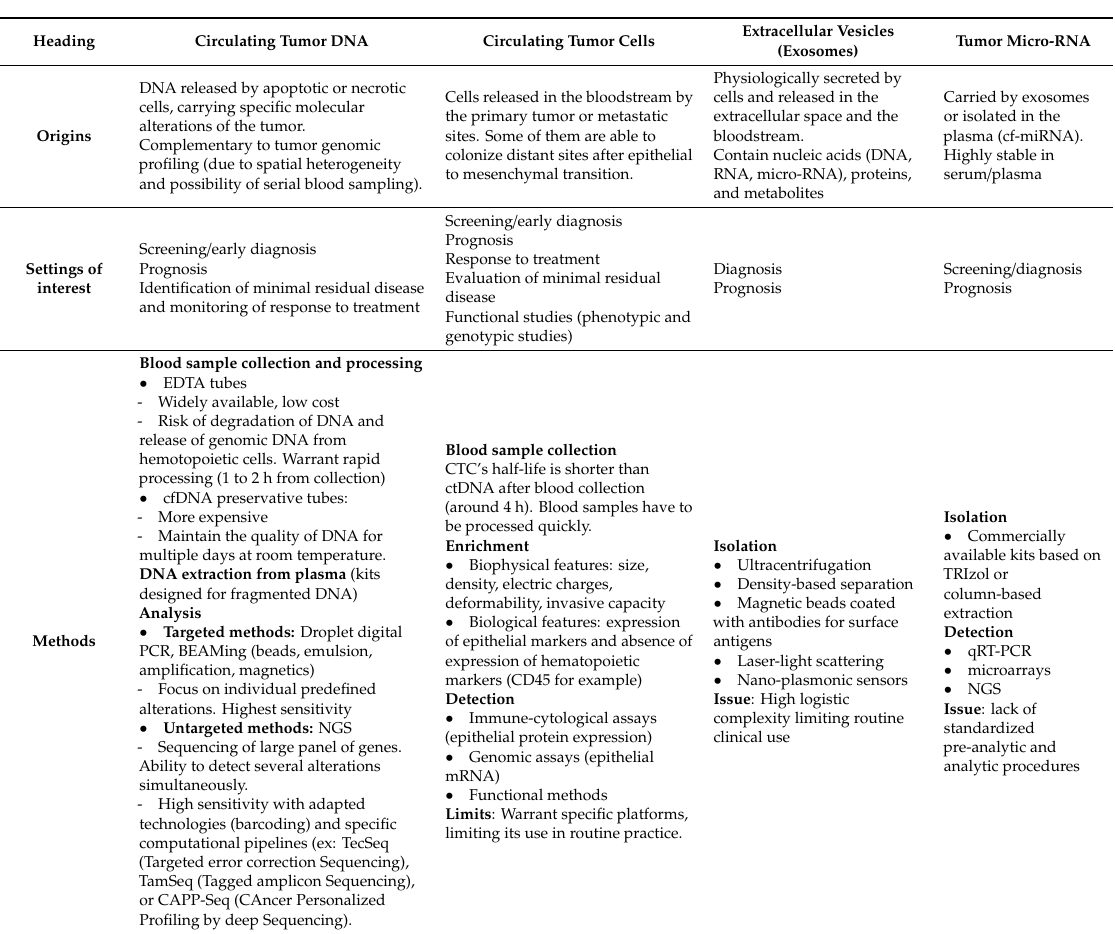
Table 3. Comparison of circulating biomarkers for ovarian cancer analysis.